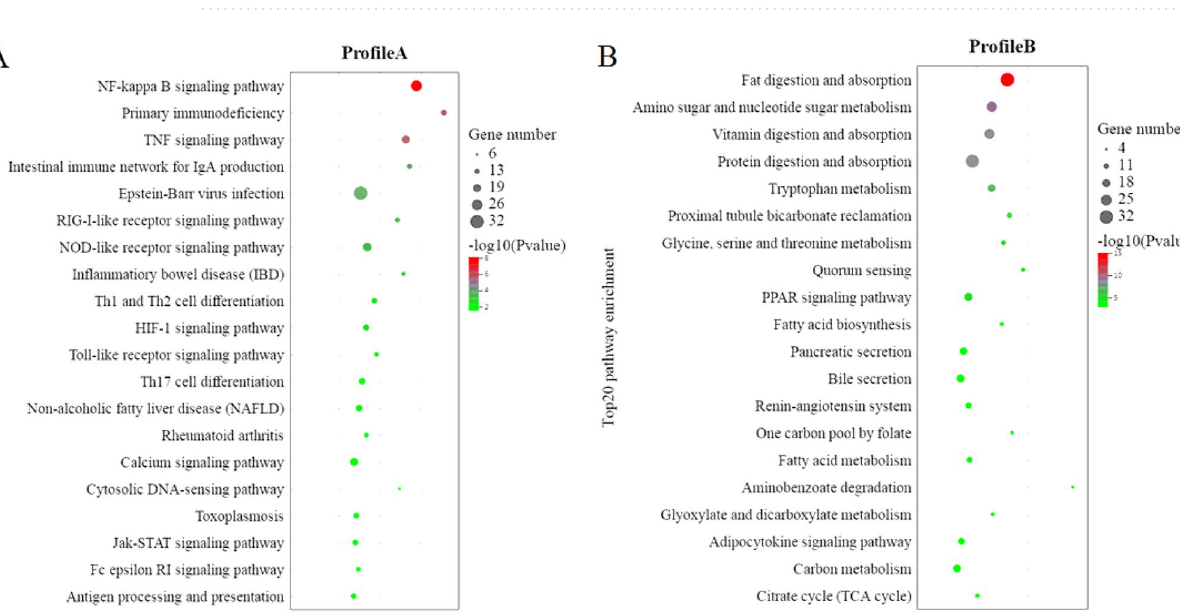
Figure 11. Significant KEGG enrichment pathways of DEGs obtained from the trend analysis. Note: KEGG database was cited from Kanehisa Laboratories 30–32